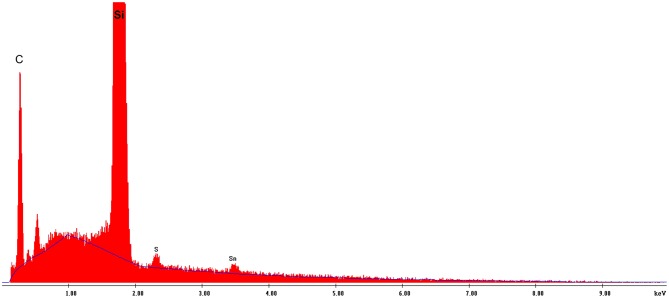
EDS analysis of the H4TPPS42--Sn(IV)TPPyP4+ nanotubes formed in an equimolar solution at pH = 2.0.